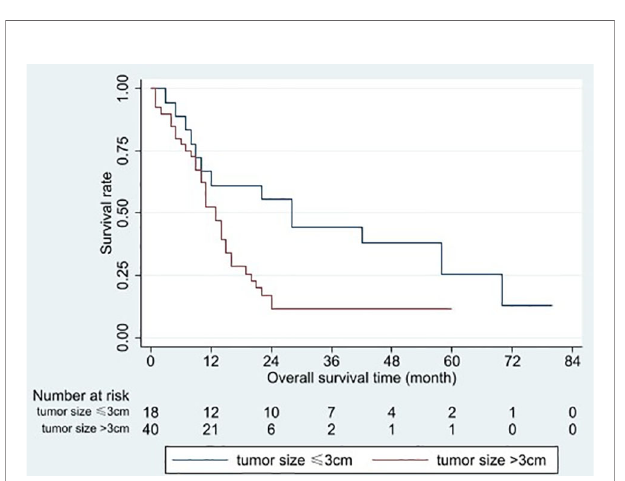
FIGURE 4 | Overall survival curves for different histopathological tumor types. Patients with squamous carcinoma had the poorest overall prognosis (p =